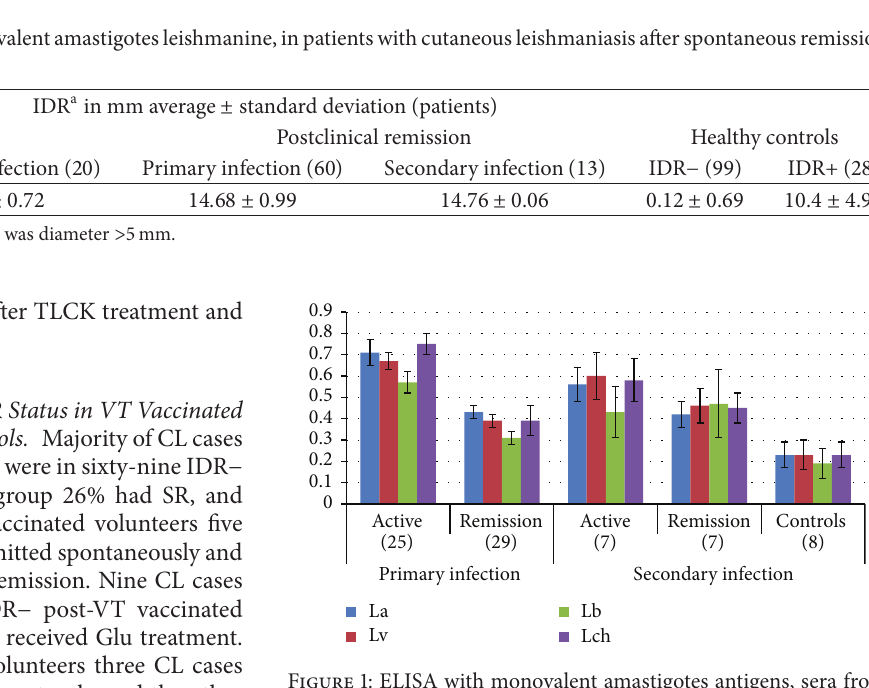
were effective and similar to natural SR (golden standard) in CL patients. Interestingly, OD values post-Glu in patients that had no remission of lesions were higher than post-SR, post-VT or post-Glu with remission of lesions ( 𝑃 < 0.05 ), pointing out ELISA as a good tool to follow up evolution of CL infection (Figure